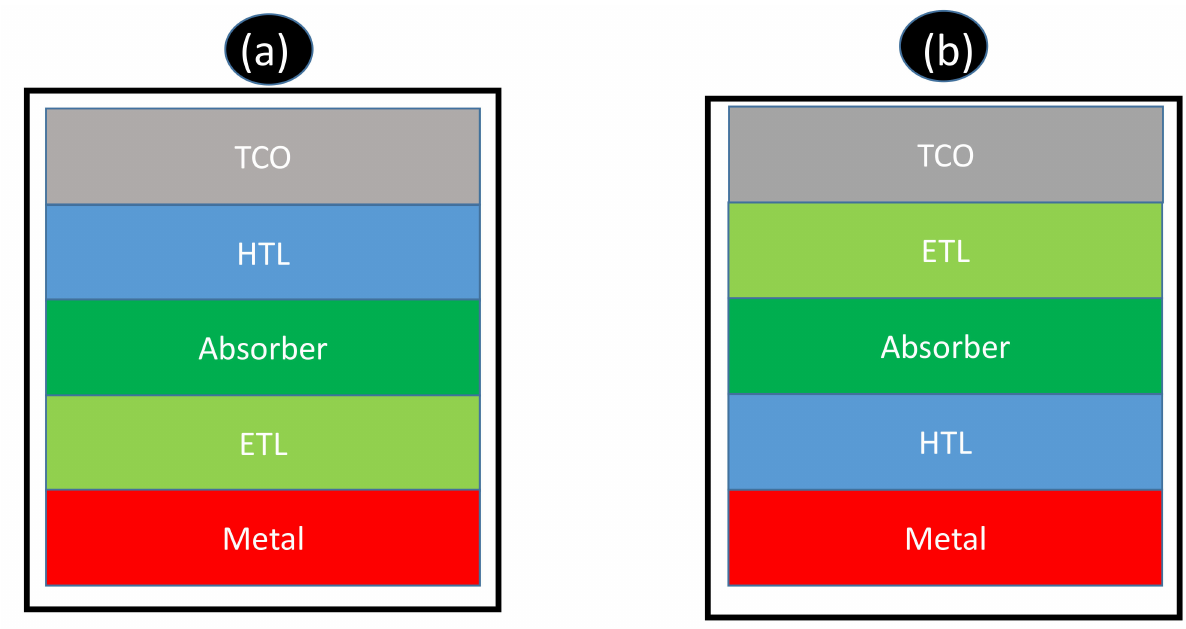
Figure 6. Schematic representation a ( a ) typical solar cell and ( b ) inverted solar cell architecture. Transparent conducting oxide(s) are conventionally chosen as an anti-reflective coater (ARC), as well as the conducting anodic electrode on the front side of the cell. Normally, TCO layers with a thickness in the range 70 to 150 nm in silicon-based solar cells are desired to promote adequate transmission of light to the absorbing material and minimize optical losses. Researchers reported more than 90% minimal sheet resistance and smooth surface morphologies when the TCO layer, mostly indium tin oxide (ITO) is between 80 to 180 nm